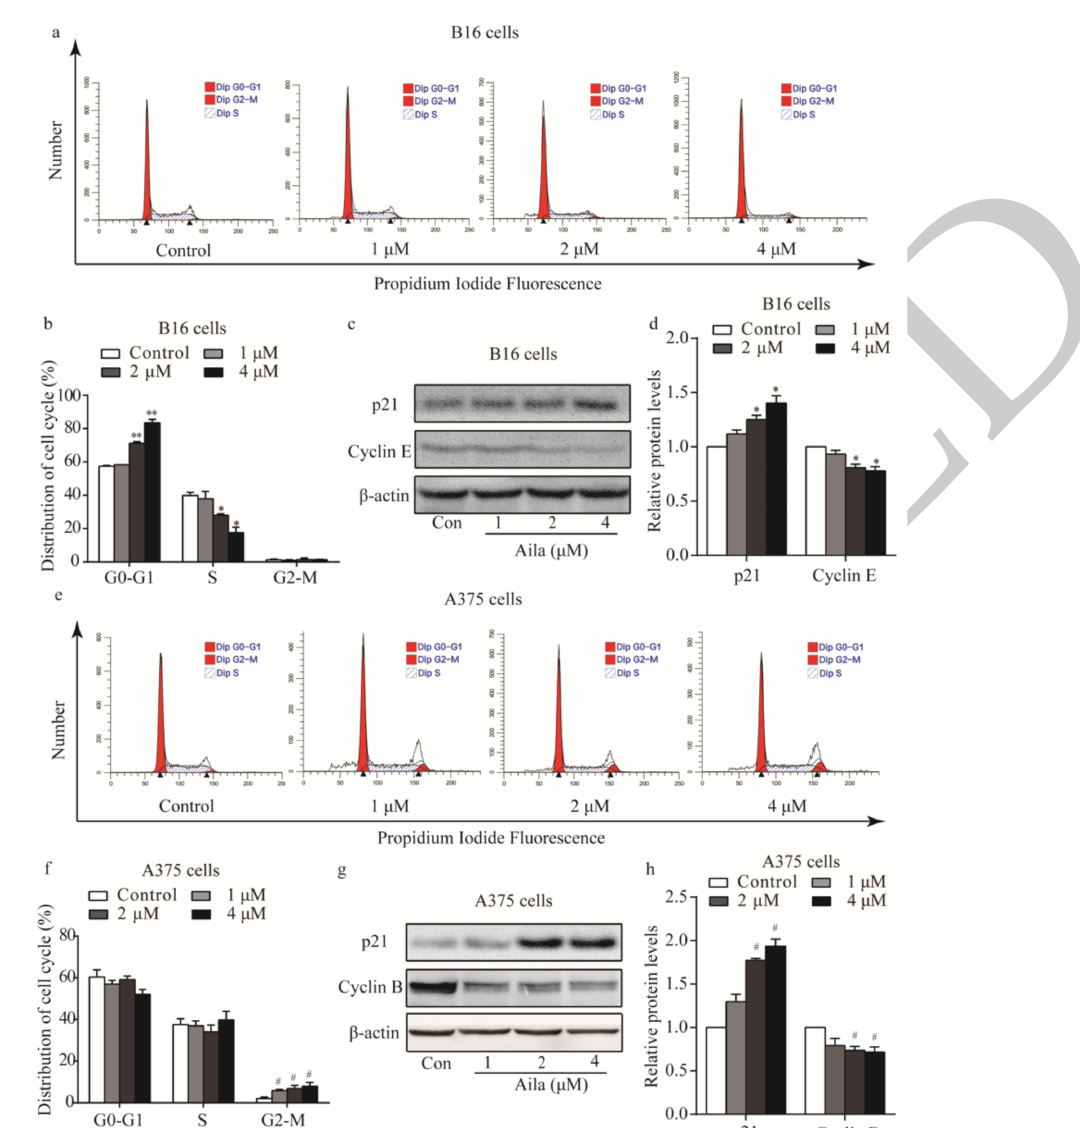
Figure 3. Ailanthone induces cells cycle arrest and regulates cell cycle-related proteins in melanoma B16 and A375 cells. ( a ) Cell cycle distributions of the B16 cells were measured by flow cytometry after treatment with various concentrations of ailanthone for 24 h. ( b ) Statistical analysis of the cell cycle distribution of ailanthone-treated B16 cells. * p < 0.05, ** p < 0.01 compared with the control B16 cells. ( c ) The levels of p21 and cyclin E in ailanthone-treated B16 cells were examined by Western blotting. ( d ) Quantitative analysis of the levels of p21 and cyclin E in ailanthone-treated B16 cells. * p < 0.05, ** p < 0.01 compared with the control B16 cells. ( e ) Cell cycle distribution of the A375 cells was measured by flow cytometry after treatment with various concentrations of ailanthone for 24 h. ( f ) Statistical analysis of cell cycle distributions of the ailanthone-treated A375 cells. # p < 0.05, ## p < 0.01 compared with the control A375 cells. ( g ) The levels of p21 and cyclin B in ailanthone-treated A375 cells were examined by Western blotting. ( h ) Quantitative analysis of the levels of p21 and cyclin B in ailanthone-treated B16 cells. # p < 0.05, ## p < 0.01 compared with the control A375 cells. The data are presented as the mean ± SD ( n =